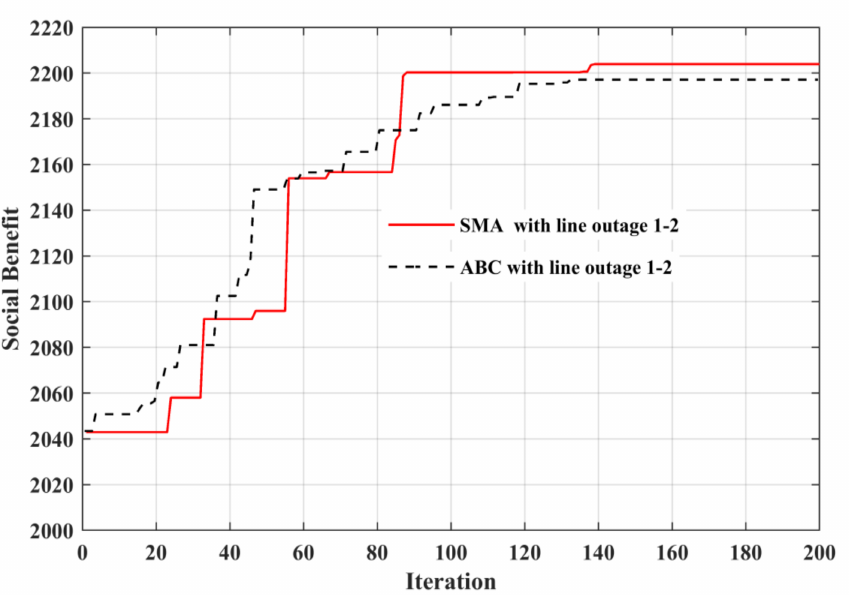
Figure 7. Comparative convergence characteristics under the deregulated environment in IEEE 30 bus